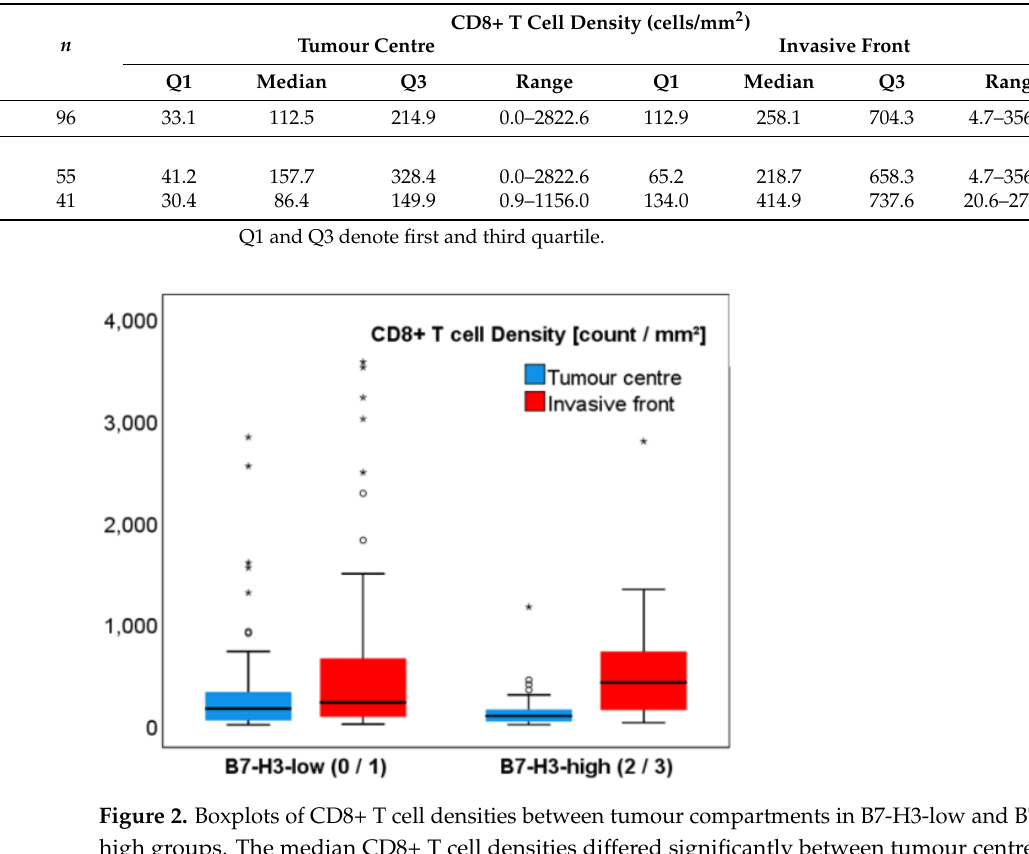
Table 2. The median density of CD8+ T cells between tumour compartments in relation to B7-H3 expression.